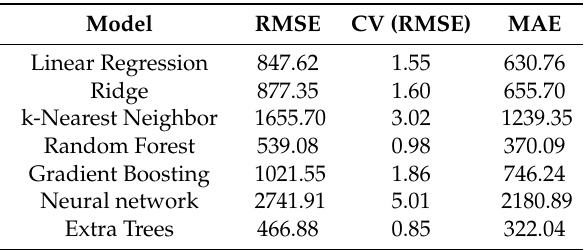
Table 2. Performance Metrics of Machine Learning